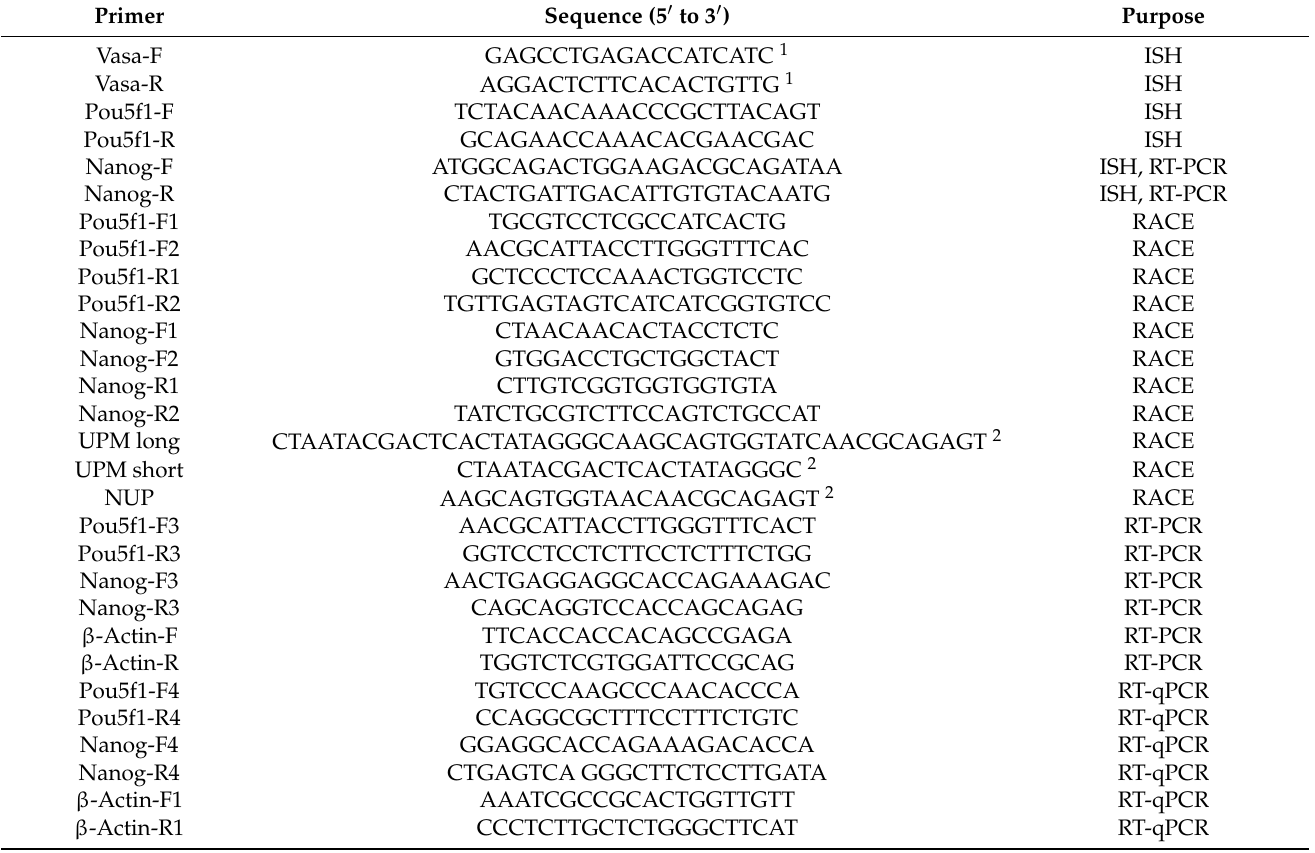
Table 1. Primers for synthesizing RNA probes, cloning the full-length cDNAs, and analyzing gene expression